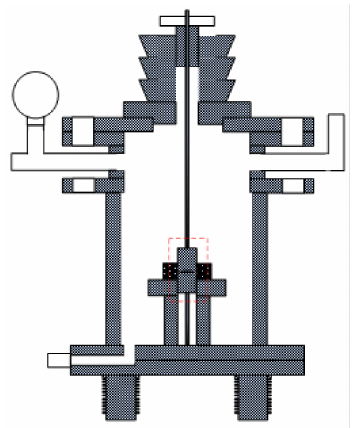
Figure 4. The oil-film dielectric